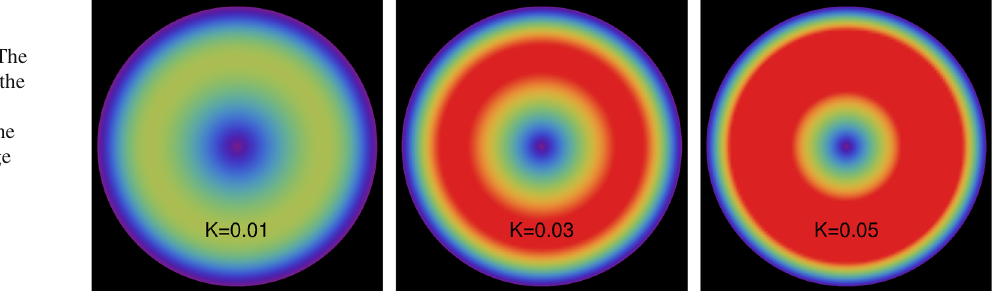
Fig. 3 Radial pressure [ 6 ˜ p r ( r , K ) × 10 3 ] as a function of ( r , K ) for n = 2 (left panel) and [ 6 ˜ p r ( r , n ) × 10 3 ] as function of ( r , n ) for K = 0 . 01 (right panel). The radial pressure decreases from the center (red color) towards the surface (violet color) Fig. 4 Exchange of energy [ 2 Δ E × 10 4 ] for n = 2 and three different values of K . The red colored regions indicate the location where the exchange reach its maximum value. The region of maximum exchange grows as K